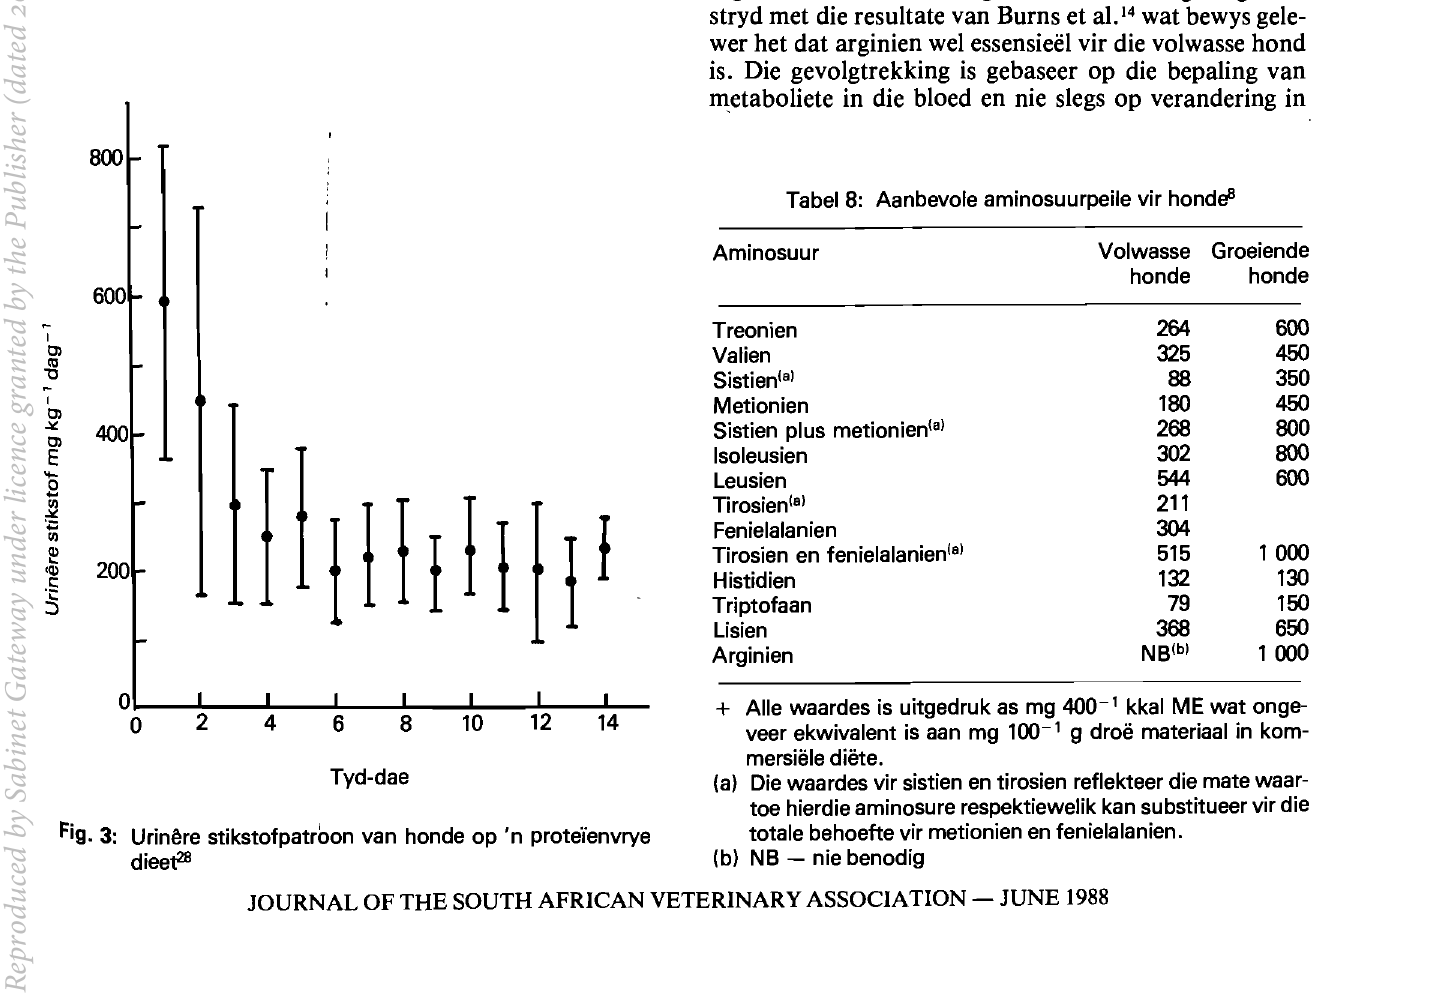
Tabel 8: Aanbevole aminosuurpeile vir